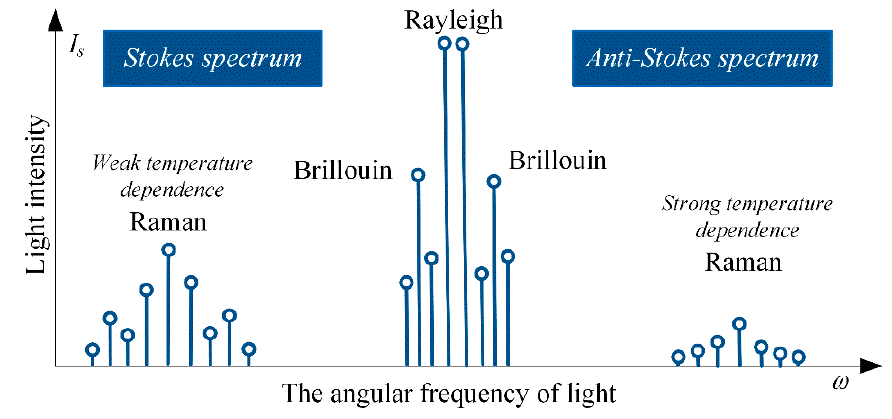
Figure 1. Spontaneous scattering in optical fiber.